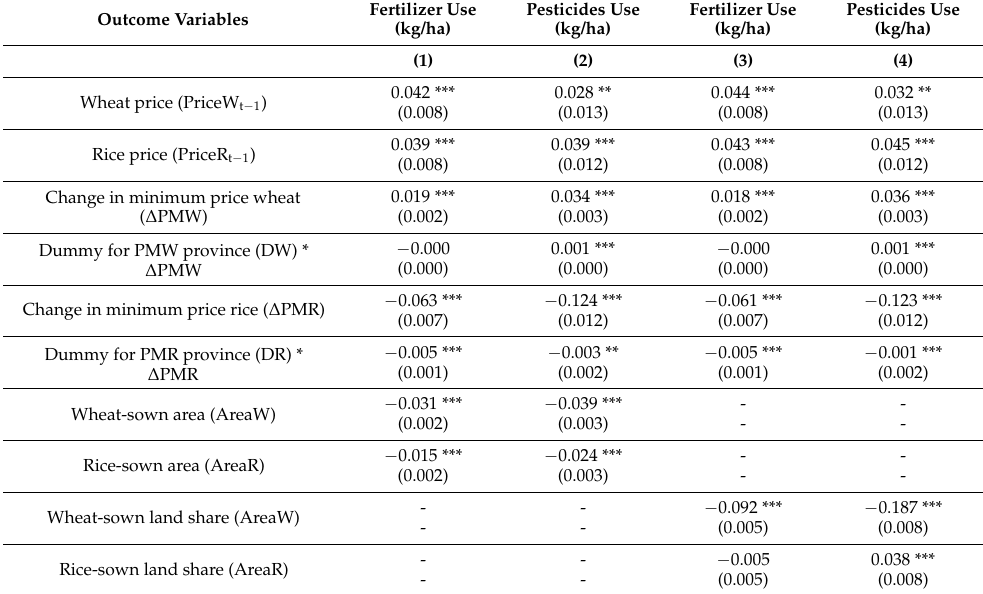
Table A2. Main estimated elasticities for agrochemical use. Outcome